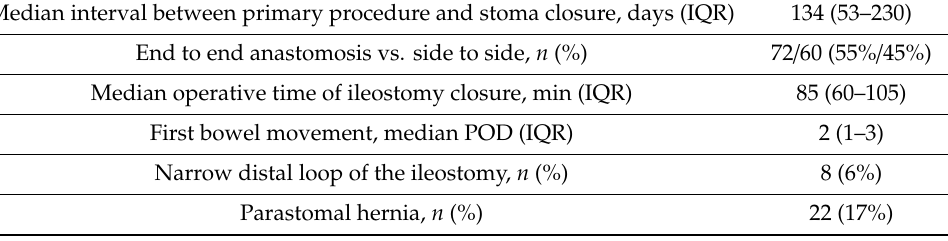
Table 2. Basic data of the patients before ileostomy reversal.